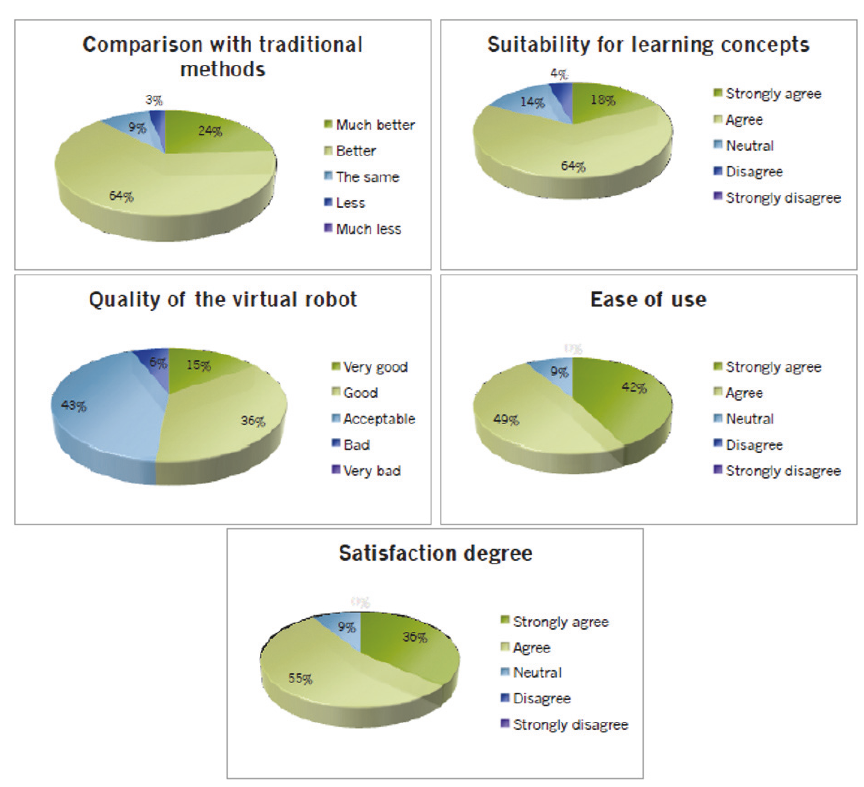
Figure 13: Results of the Turtle Robot course students questionnaire, from